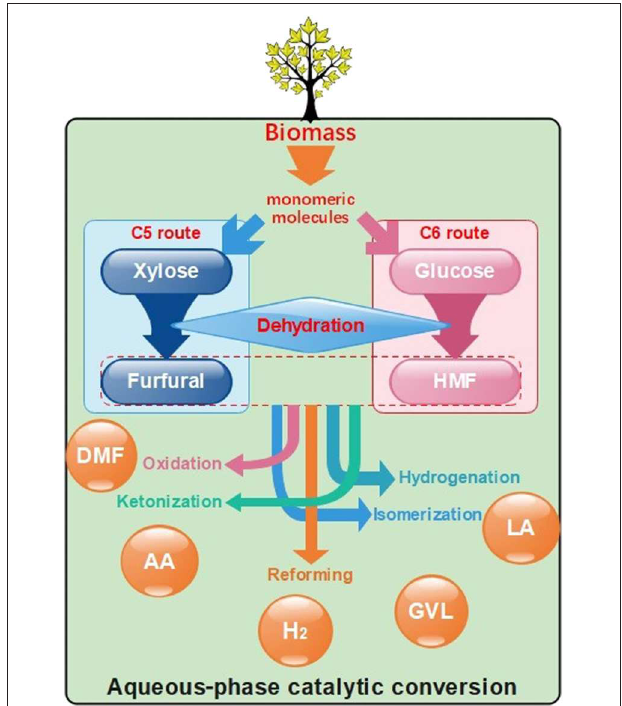
FIGURE 1 | A general conversion route of